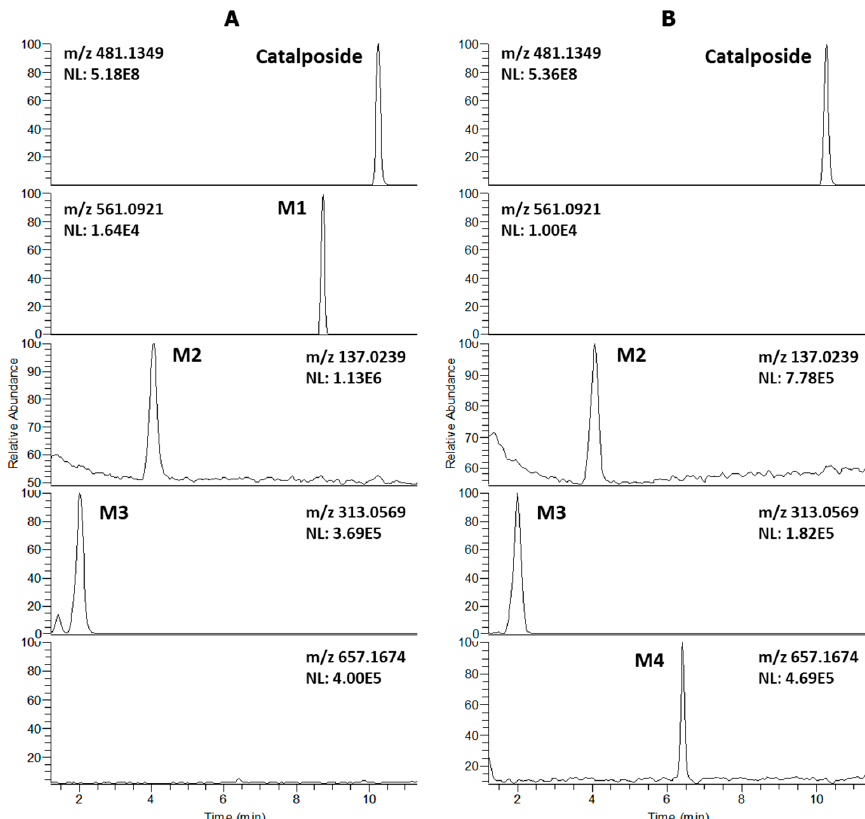
Figure 1. Extracted ion chromatograms of catalposide and its possible metabolites after incubation of 200 µ M catalposide with ( A ) human hepatocytes for 2 h at 37 ◦ C in a CO 2 incubator and ( B ) human intestinal microsomes in the presence of UDPGA at 37 ◦ C for 1 h (mass accuracy: 5 ppm). The extracted ion chromatograms were reconstructed based on the [M–H] − ions: m / z 481.1349 for catalposide, m / z 561.0921 for M1 (catalposide sulfate), m / z 137.0239 for M2 (4-hydroxybenzoic acid), m / z 313.0569 for M3 (4-hydroxybenzoic acid glucuronide), and m / z 657.1674 for M4 (catalposide glucuronide).